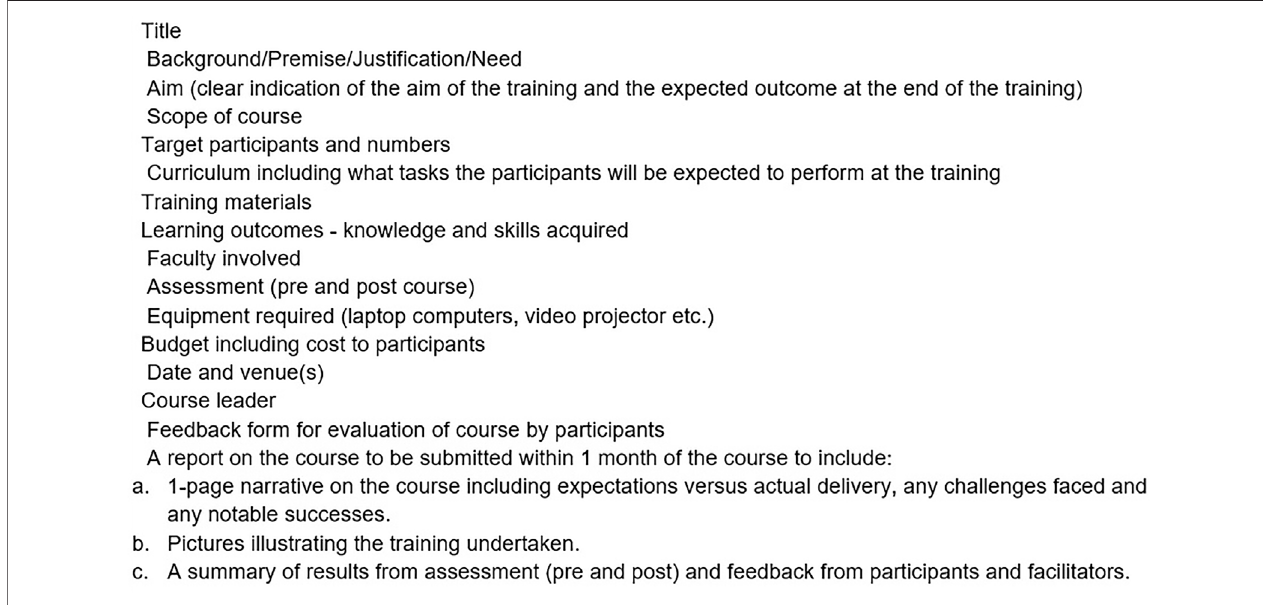
FIGURE 1 | Training